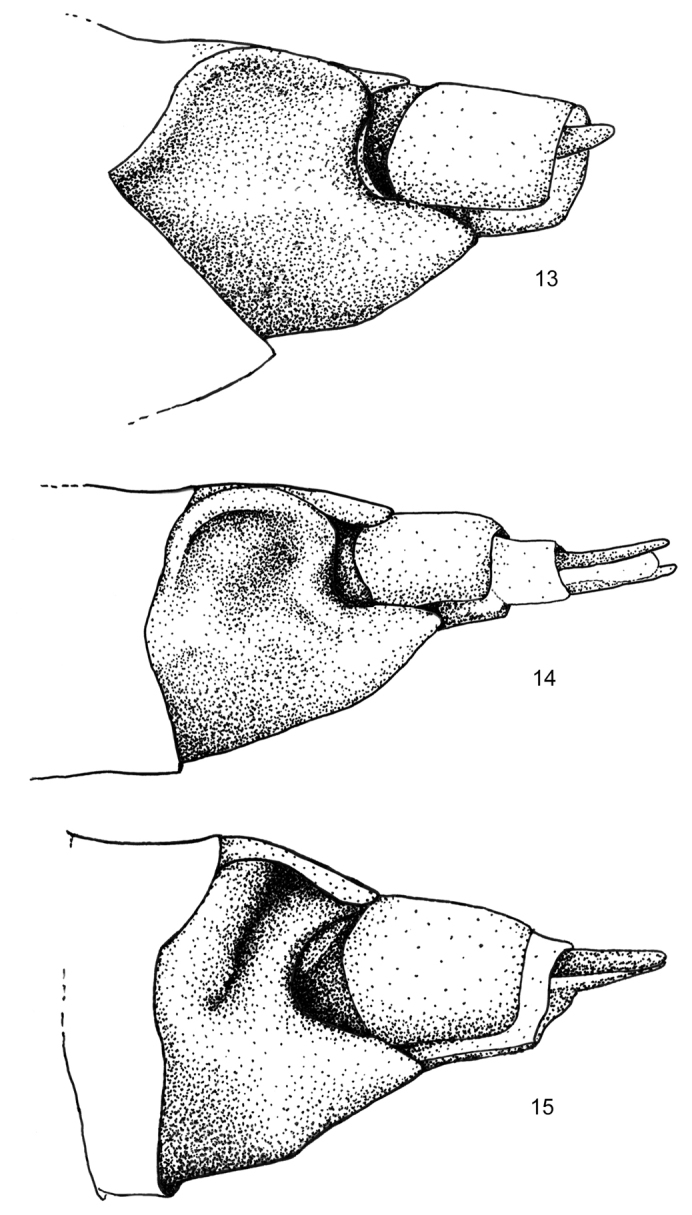
Rhabdorthodes females. Distal abdomen (scales removed), left ventrolateral aspect showing sculpted sternite A7. 13R.pattersoni14R.durango15R.petersoni.